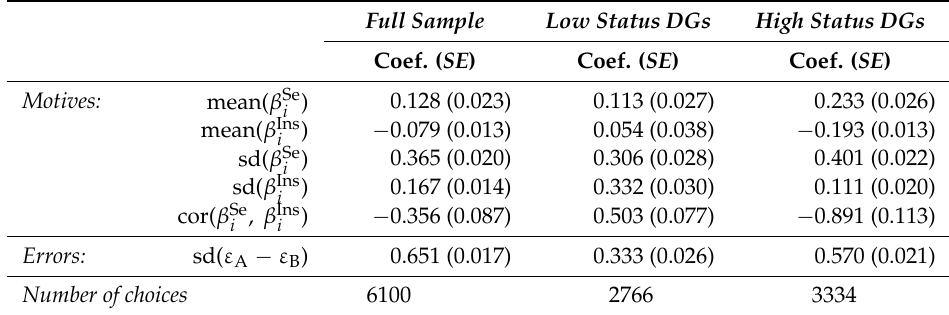
Table 9. Frequentist Estimates of the Population Distribution of Social Motives in Low-status and High Status DGs. Full Sample Low Status DGs High Status DGs Coef. ( SE ) Coef. ( SE ) Coef. ( SE